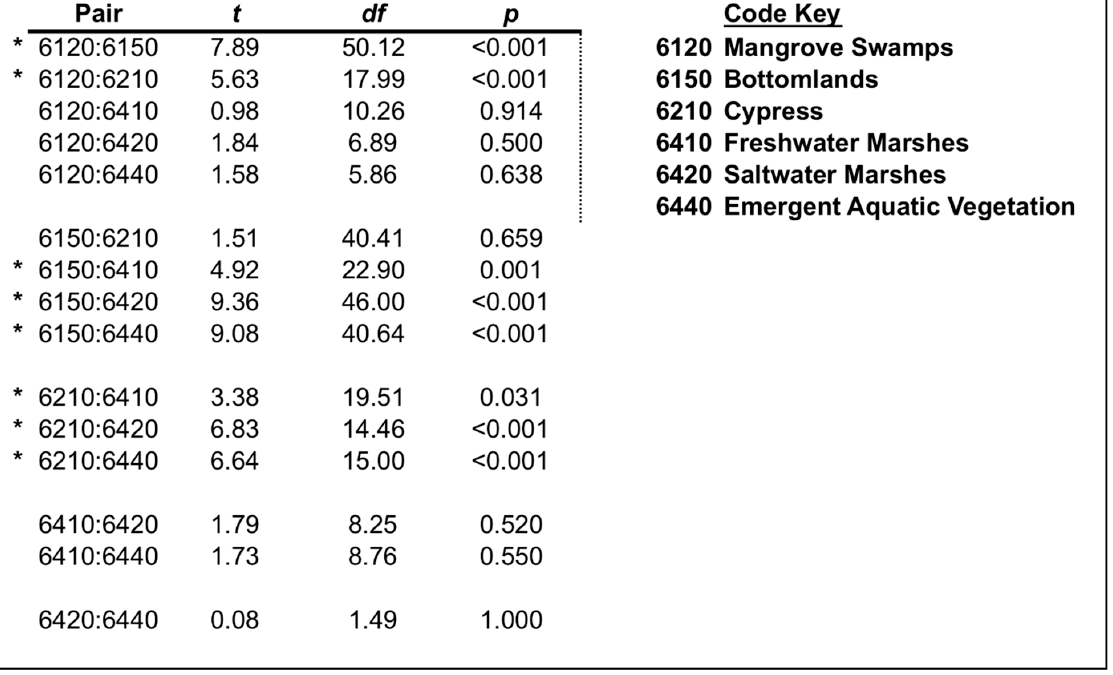
Figure 4. Games–Howell pairwise comparisons of AGTC kg plot − 1 between sub-classes of the “Wetlands” Level I SWFWMD class. Significantly different sub-classes (at α = 0.05) are denoted with an asterisk.